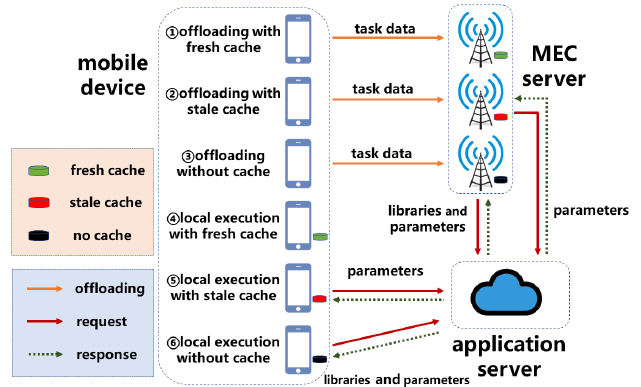
Figure 1. Schematics of the offloading